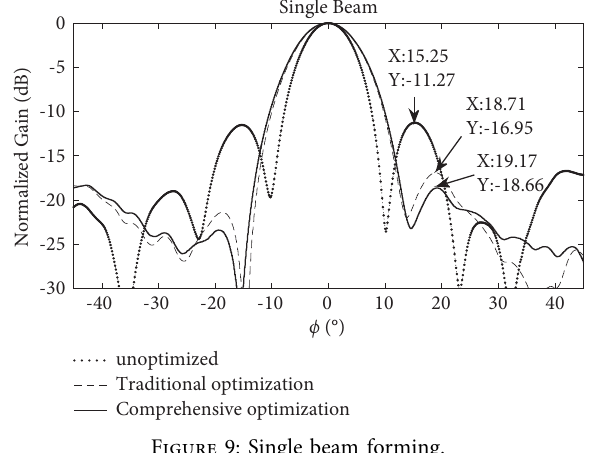
Figure 9: Single beam forming.